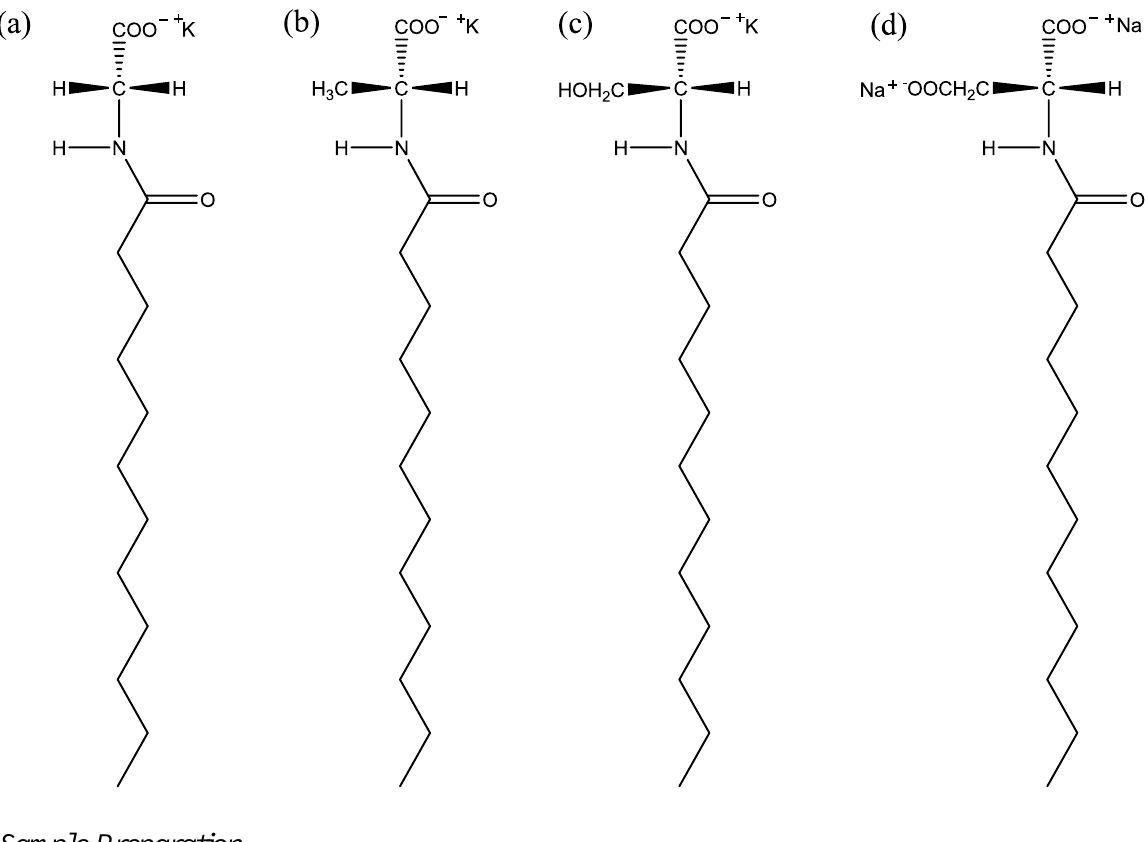
Figure 10. The molecular structures of N -dodecanoylamino acid surfactants: ( a ) KDDGly; ( b ) D -KDDA; ( c ) D -KDDS; and ( d ) D -NaDDAs. For ( b ), ( c ) and ( d ), their mirror images give corresponding L -enantiomers, i.e ., L -KDDA, L -KDDS and L -NaDDAs, respectively. DL -racemic mixtures are composed of a 50:50 percent of D - and L